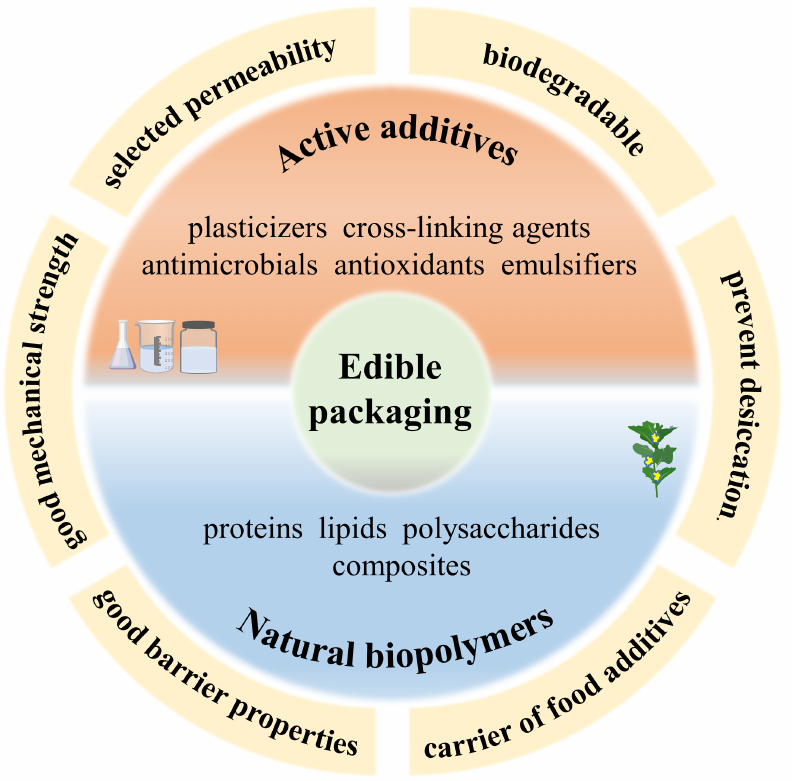
Figure 3. Major structural matrix and characteristics of edible films and